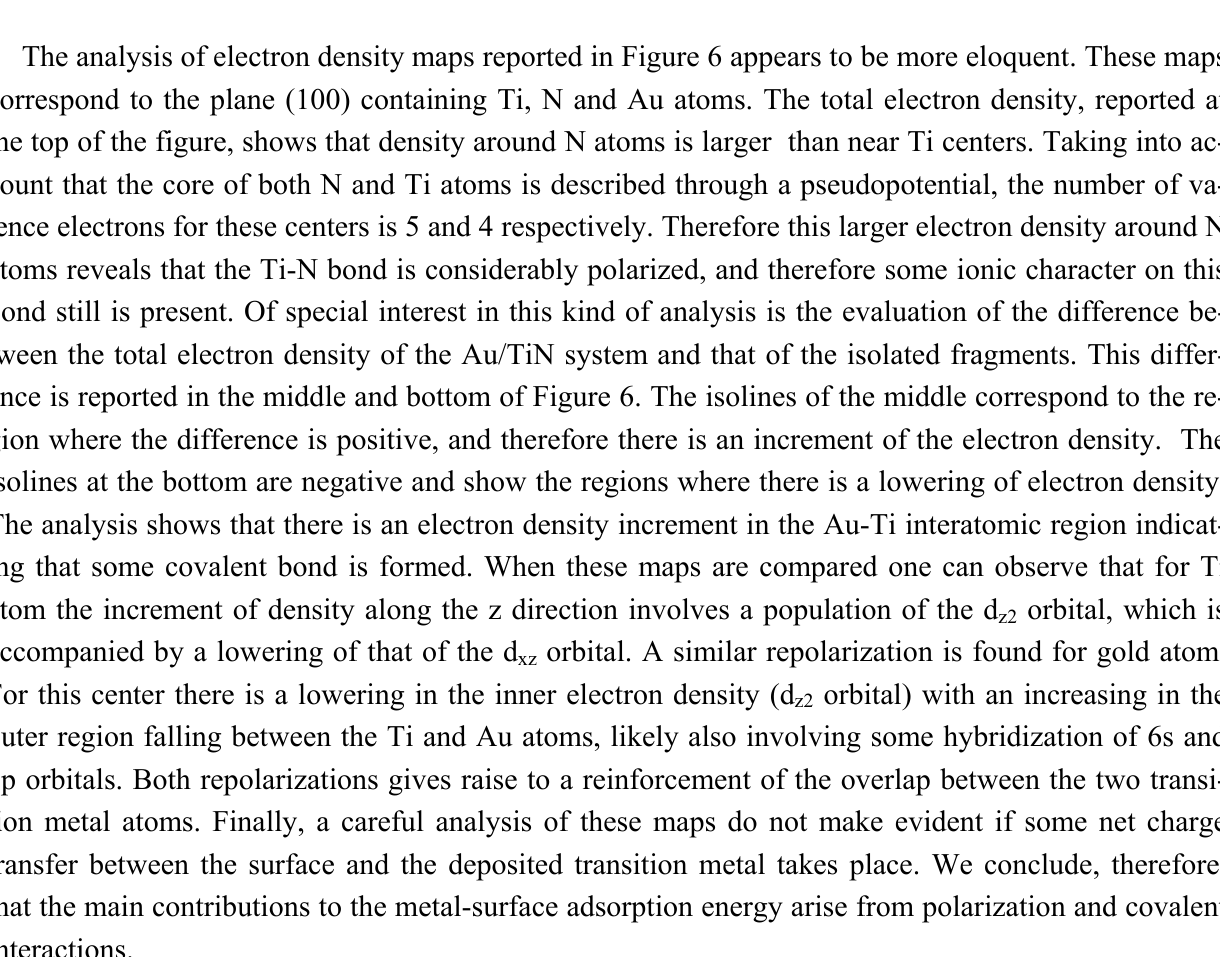
Figure 5. DOS curves for Au adsorbed on-top of Ti surface atoms obtained from periodic GGA DFT calculations. Top: projected on Au; middle: projected on Ti; bottom: projected on